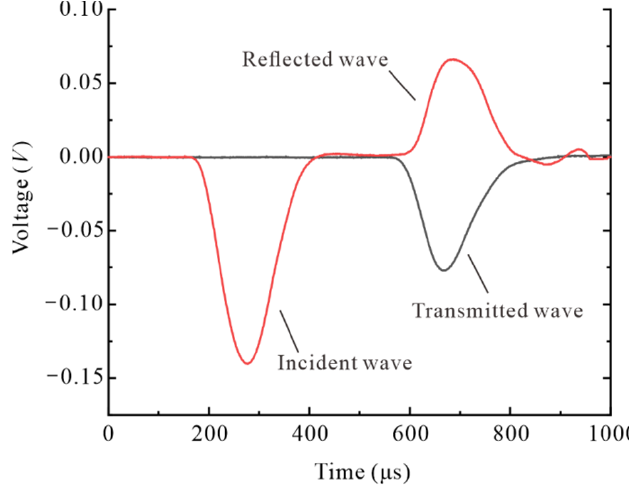
Figure 3. SHPB test incident wave, reflected wave and transmitted wave curves.